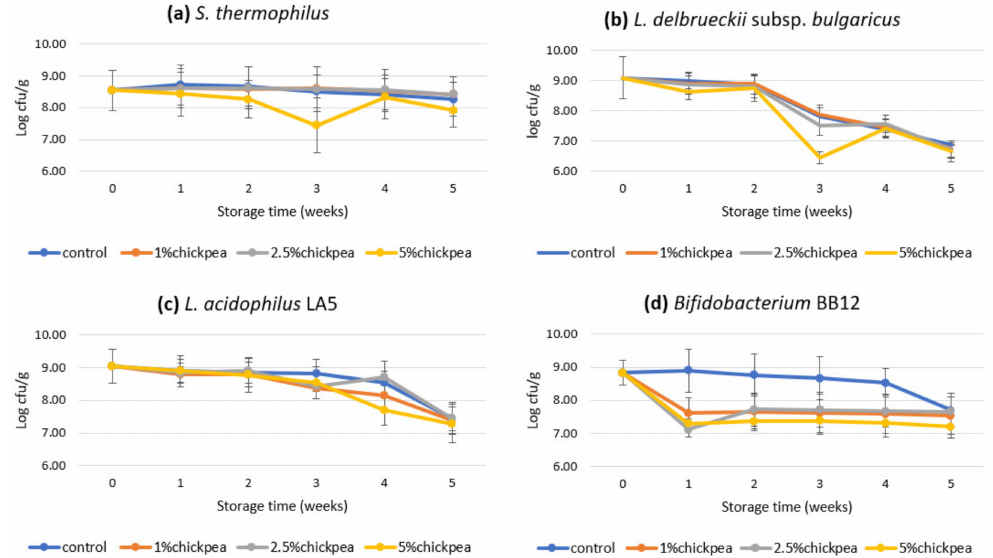
Figure 1. Viability of ( a ) S. thermophilus , ( b ) L. delbrueckii subsp. bulgaricus , ( c ) L. acidophilus LA5 and ( d ) Bifidobacterium BB12 in fortified yogurt with chickpea flour during 5-week storage at 4 ◦ C (mean ±